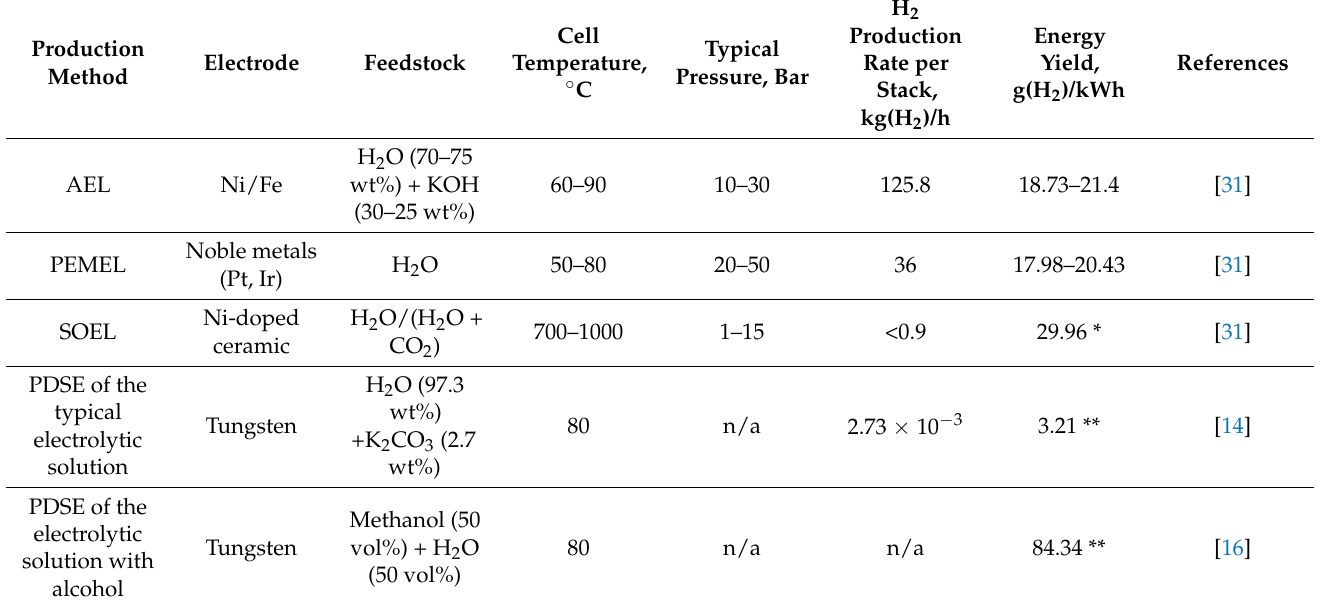
Table 5. Comparison of hydrogen production by alkaline electrolysis (AEL), polymer electrolyte mem- brane electrolysis (PEMEL), solid oxide electrolysis (SOEL), and plasma-driven solution electrolysis